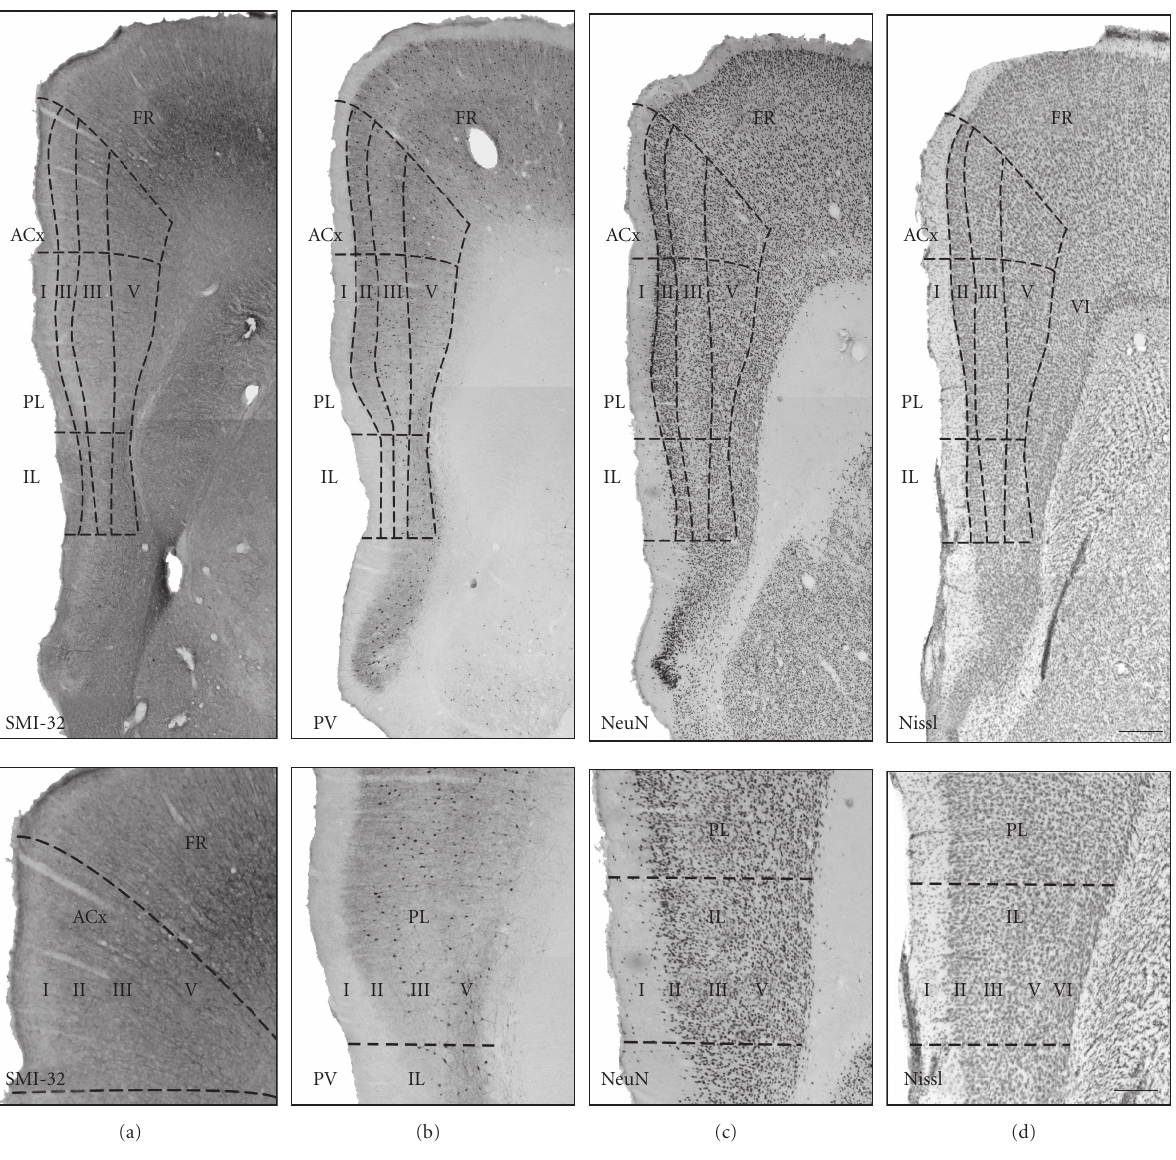
Figure 1: Boundaries of the PFC subareas in the rat visualized with antibodies. In the anterior PFC (3 . 70 − 2 . 20 mm from bregma), three subareas can be distinguished: IL, PL, and ACx. Pictures in the lower panels show the same sections at higher magnification. (a) Staining with the SMI-32 antibody shows the border between PL and ACx, and between ACx and premotor cortex (FR). (b) Parvalbumin (PV) is a good marker to distinguish IL from PL. The PV antibody stains neurons in layer V and in the other cortical layers in all three subareas. (c) The NeuN antibody strongly labels layer II, and also layers I–V can be easily distinguished with this antibody. (d) With Nissl staining, it is possible to distinguish layer I but not the other cortical layers. Scale bars: 500 µ